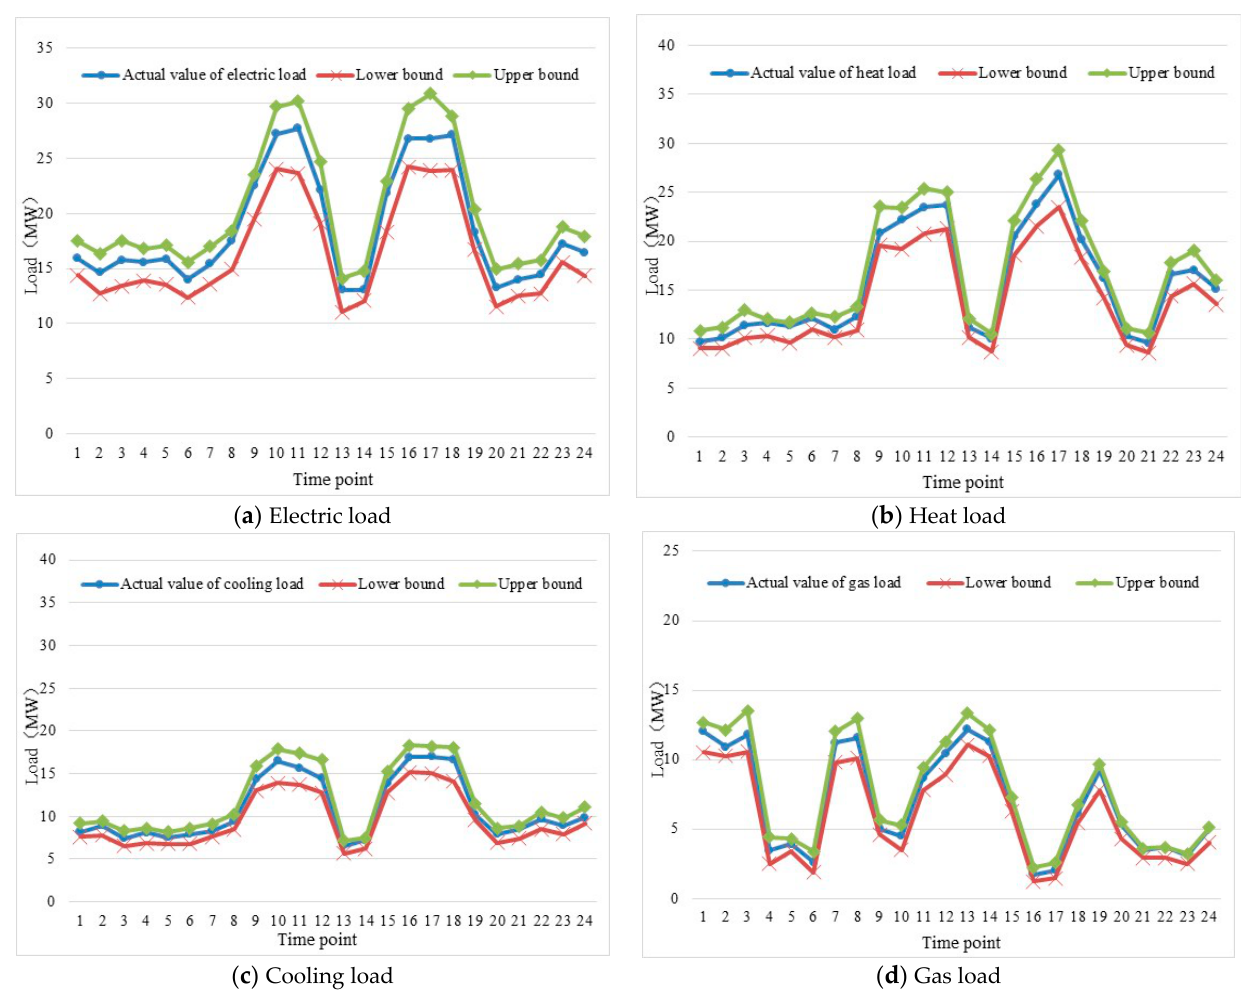
Figure 12. Multi-energy load forecasting results on the holiday